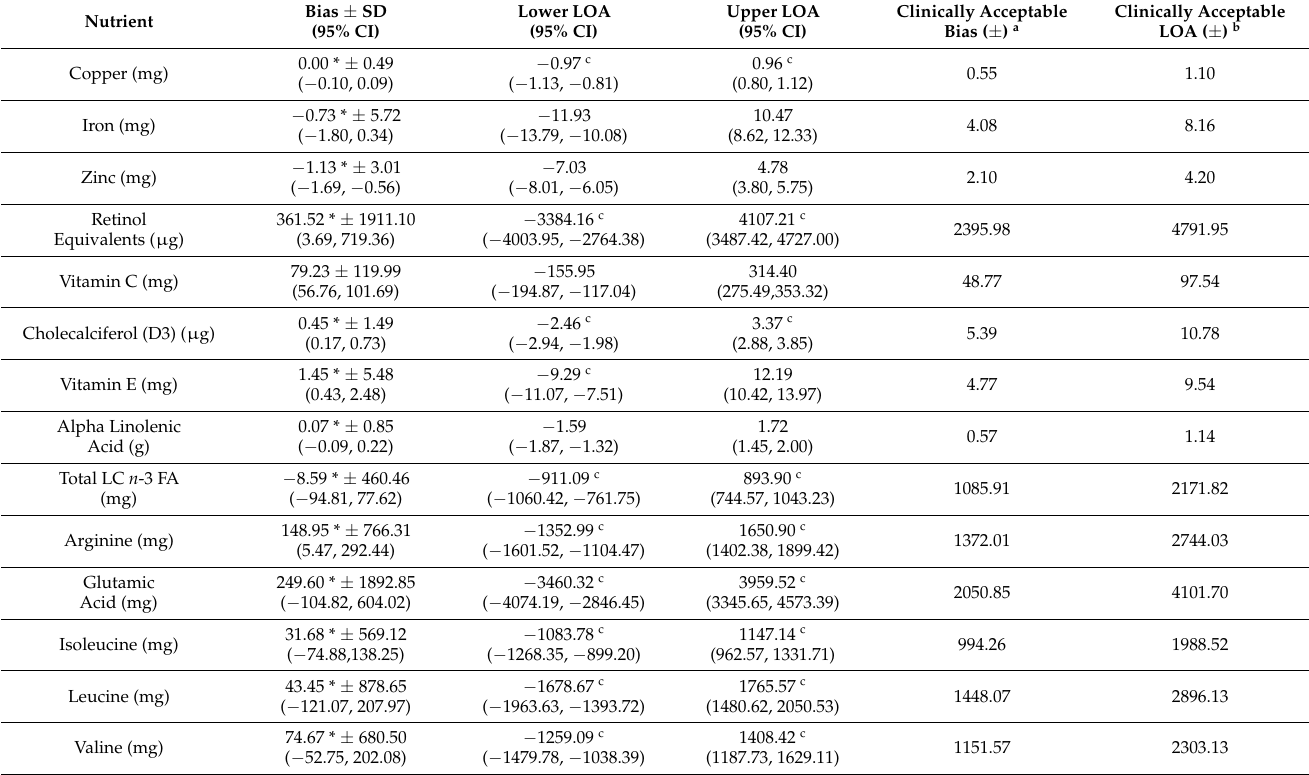
Table 2. Summary of results from Bland–Altman analysis demonstrating agreement between Food Frequency Questionnaire (FFQ) and diet history for 14 different micronutrients. Bias and standard deviation (SD) with 95% confidence intervals (95% CI), lower and upper limits of agreement (LOA) with respective 95% CI, and clinically acceptable bias and LOA ranges are